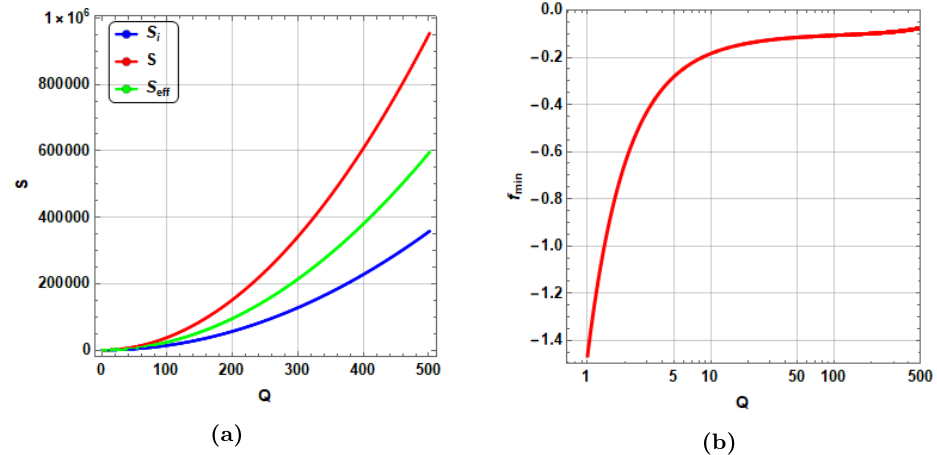
Figure 30. (a) Entropy as a function of black hole charge during absorption of 10 5 particles with a fixed electric charge dQ = 0 . 005 . (b) f min = f ( r min ) in terms of black hole electric charge during absorption of 10 5 particles with a fixed electric charge dQ = 0 . 005 . The initial conditions are Q 0 = 1 , l = 1 , M 0 = 1 . 67 , r h = 1 . 1 and D = 4